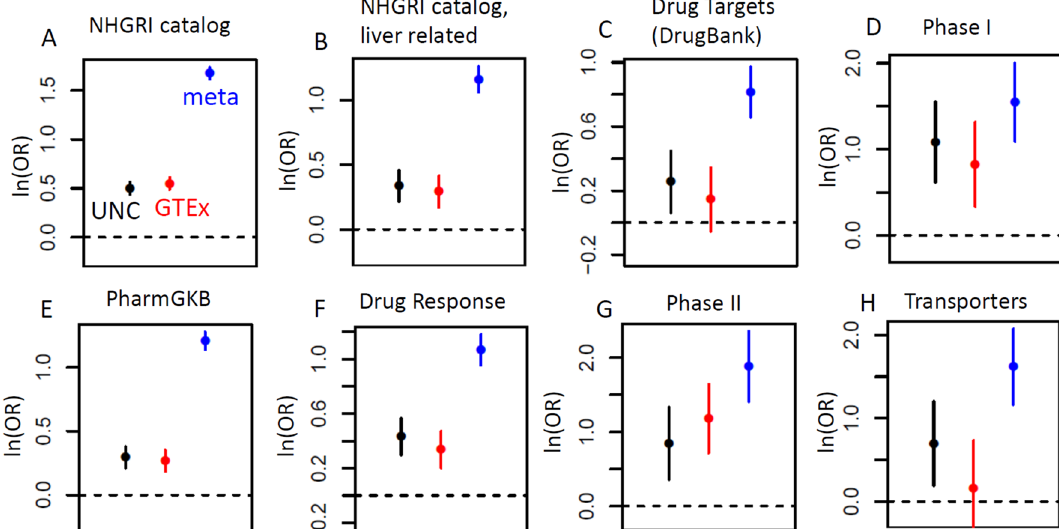
Figure 2. Enrichment of disease- and pharmacologically-relevant genes among liver eQTLs, as described in text, for UNC liver, GTEx liver, and the microarray meta-analysis. Natural logarithms of odds ratios (95% confidence intervals) are shown for enrichment of genes with cis-eQTLs with p < 10 –5 and each corresponding gene set described in text. Heterogeneity p values after Bonferroni correction were p < 0.001 for all comparisons, except for Phase I and Phase II (panels D and G), which were not significant at α =